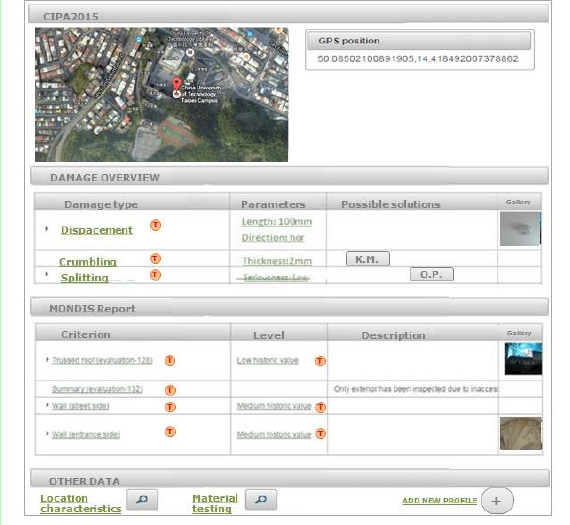
Figure 4. MONDIS explorer: record visualization